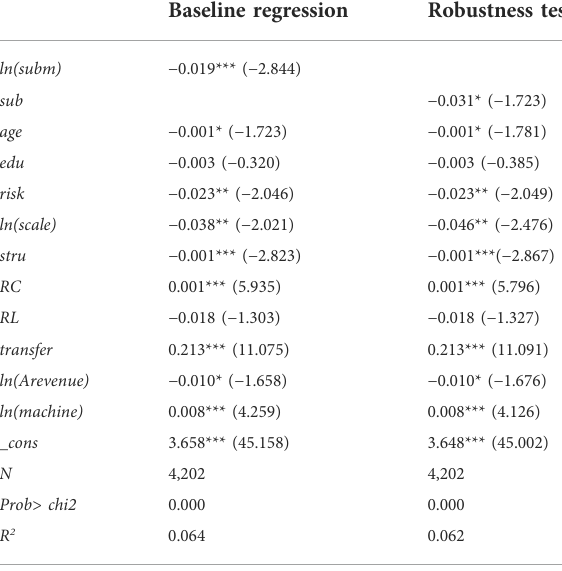
TABLE 2 Baseline regression and robustness